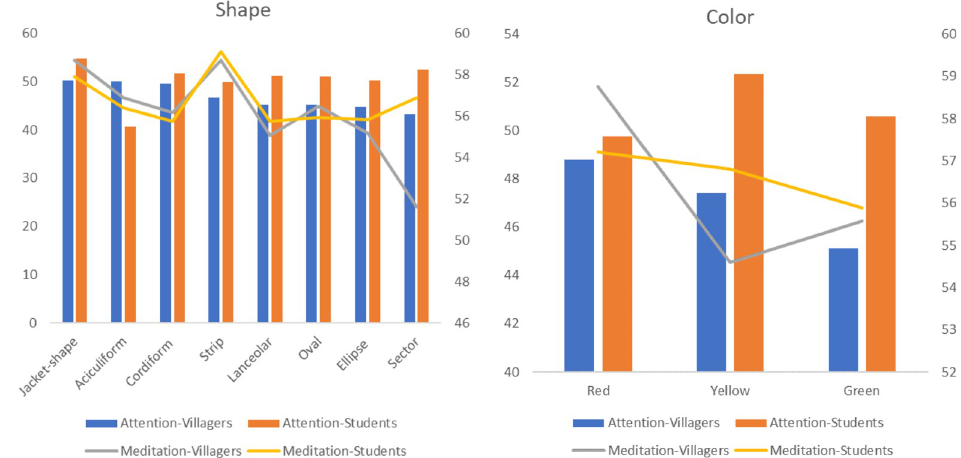
Fig 11. The average value of EEG indicators of villagers and students with different leaf shapes and colours.